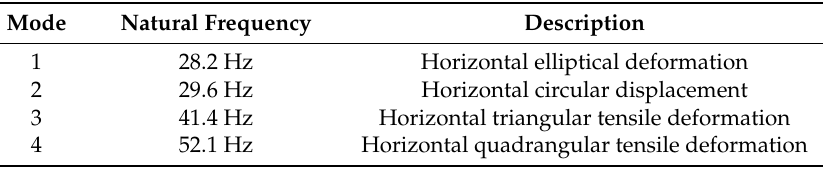
Table 4. Description of mode-shapes of the stator pack.